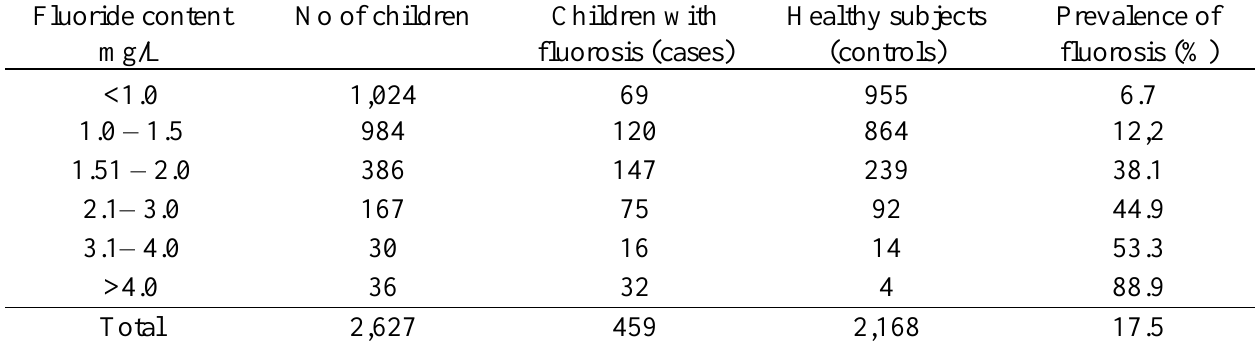
Table 3. Prevalence of dental fluorosis in different fluoride levels in drinking water.